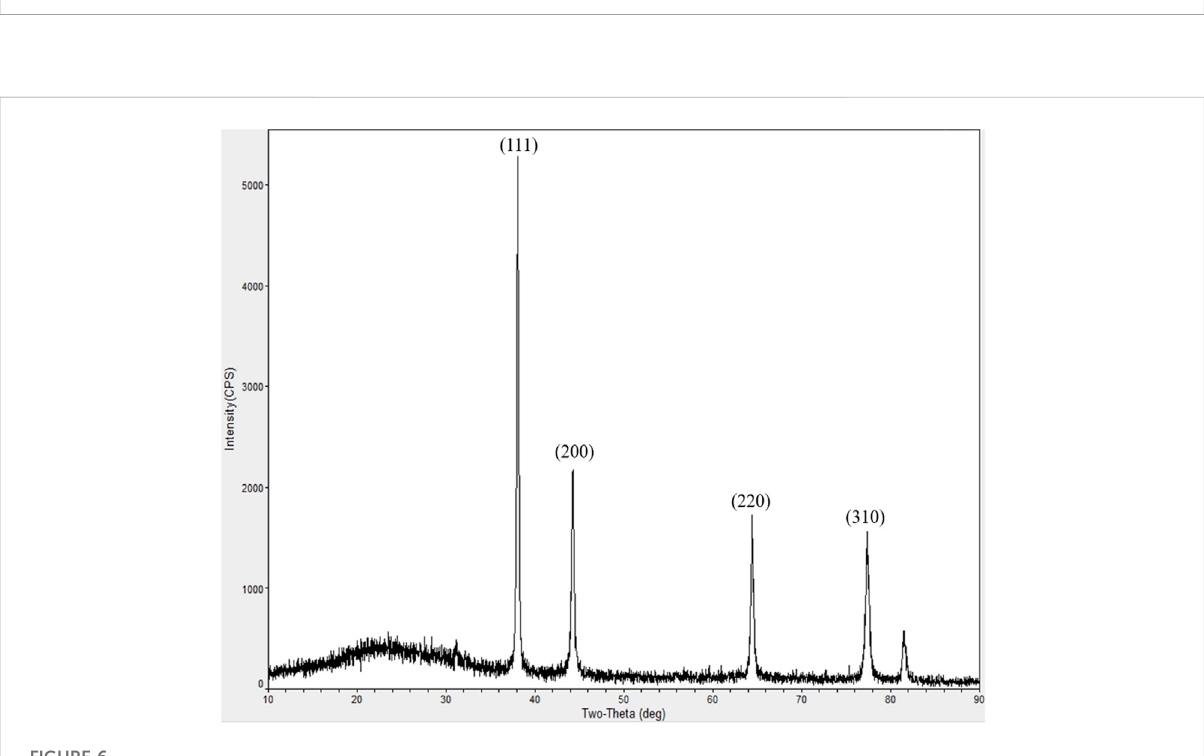
FIGURE 6 XRD analysis spectrum of